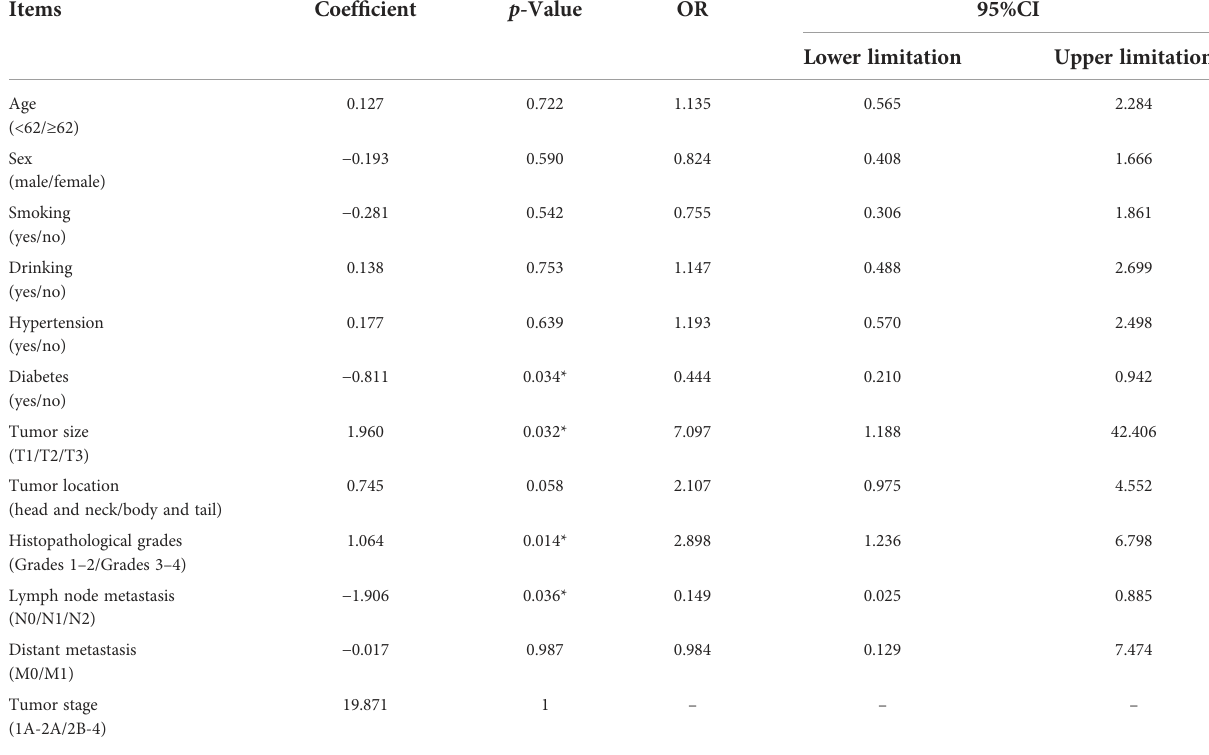
TABLE 3 Logistics analysis of GREM1 and correlated